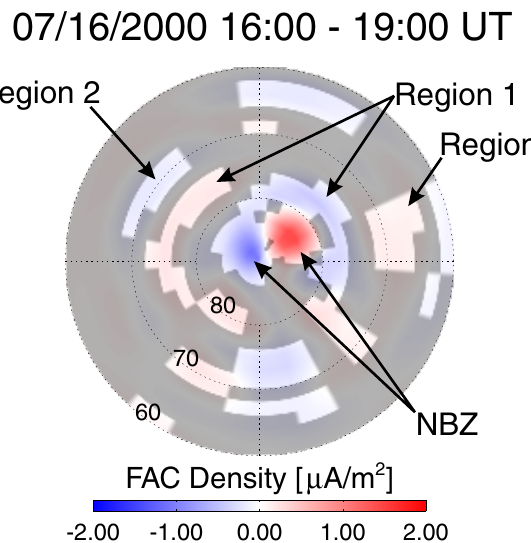
Fig. 10. Average Birkeland current distribution on 16 July 2000, from 16:00 UT to 19:00 UT in AACGM MLT-MLAT coordinates obtained from three non-overlapping hourly snapshots. Upward flowing Birkeland currents are shown in red, blue colors represent currents in the downward direction. Birkeland currents below the quiet-time baseline are masked in